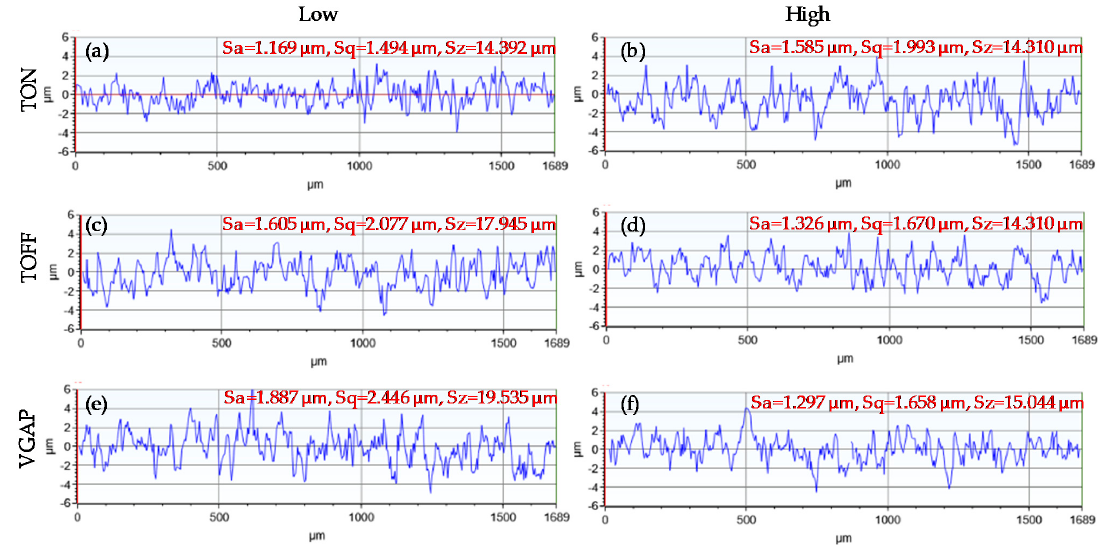
Figure 9. Roughness profiles of ( a ) low TON (1 MU) ( b ) high TON (9 MU) ( c ) low TOF (1 MU) ( d ) high TOF (9 MU) ( e ) low VGAP (35 V) ( f ) high VGAP (75 V).